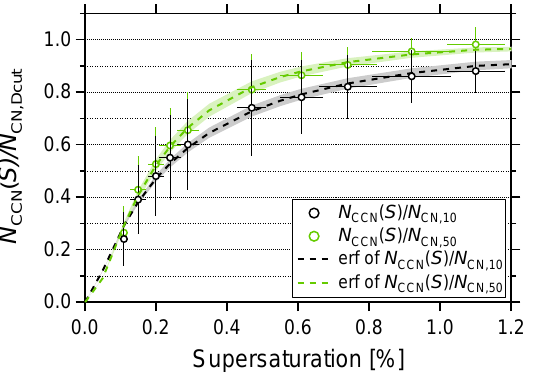
Figure 13. CCN efficiency spectra averaged over the entire mea- surement period for the reference concentrations, N CN,10 and N CN,50 . The fit functions are error function fits (the dashed line with shading represents the uncertainty of the fit). The error bars at the markers represent the measurement error in S and 1 standard de- viation (not the standard error as in Fig. 10) in N CCN ( S)/N CN ,D